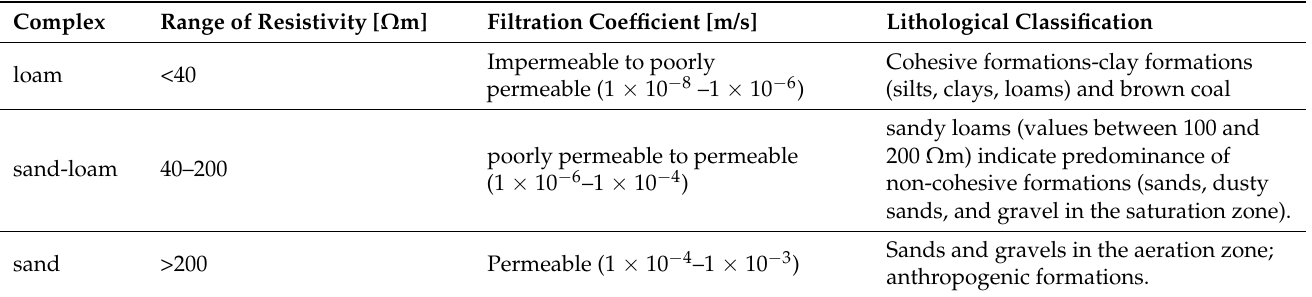
Figure 9. Diagram of interpretation of the hydrogeological conditions along profile (shown in Figure 5) in test-field three.